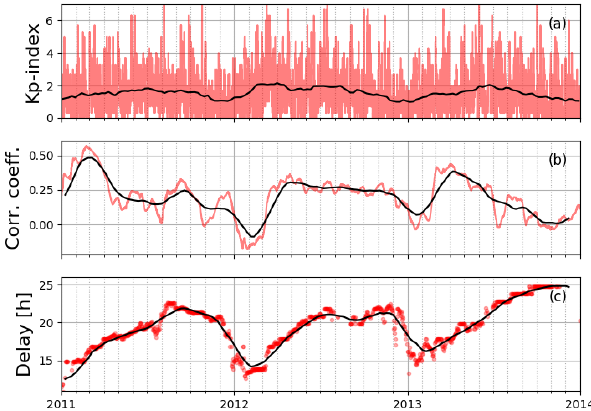
Figure 4. The transparent red lines or dots show the raw data: Kp index (a) , correlation coefficients between EUV and TEC (b) , and delays between EUV and TEC (c) at an hourly resolution. The black lines show the smoothed weekly means to present the overall trend (running mean with window size of 10d). All data correspond to the location of Rome at 41.8 ◦ N, 12.5 ◦ E.